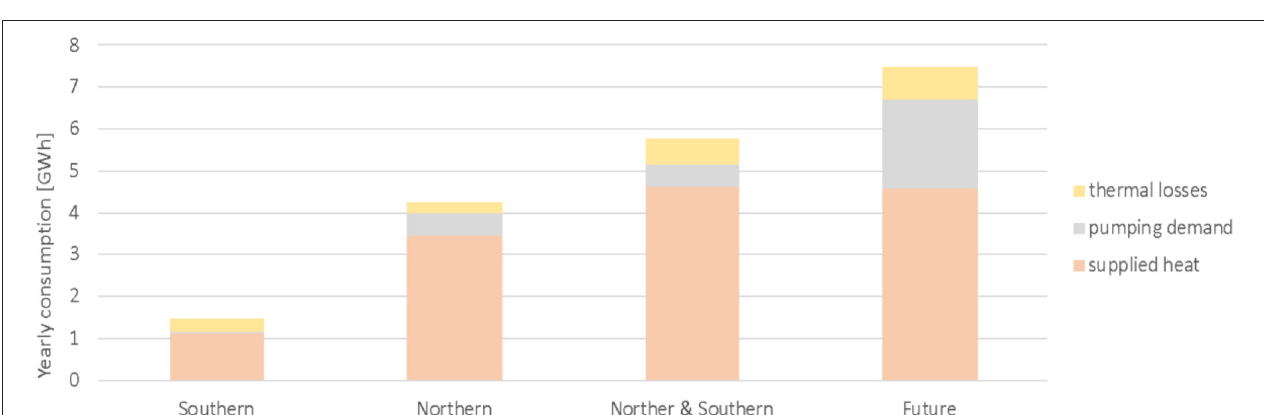
FIGURE 8 | Layout demand and pipe length per building set.